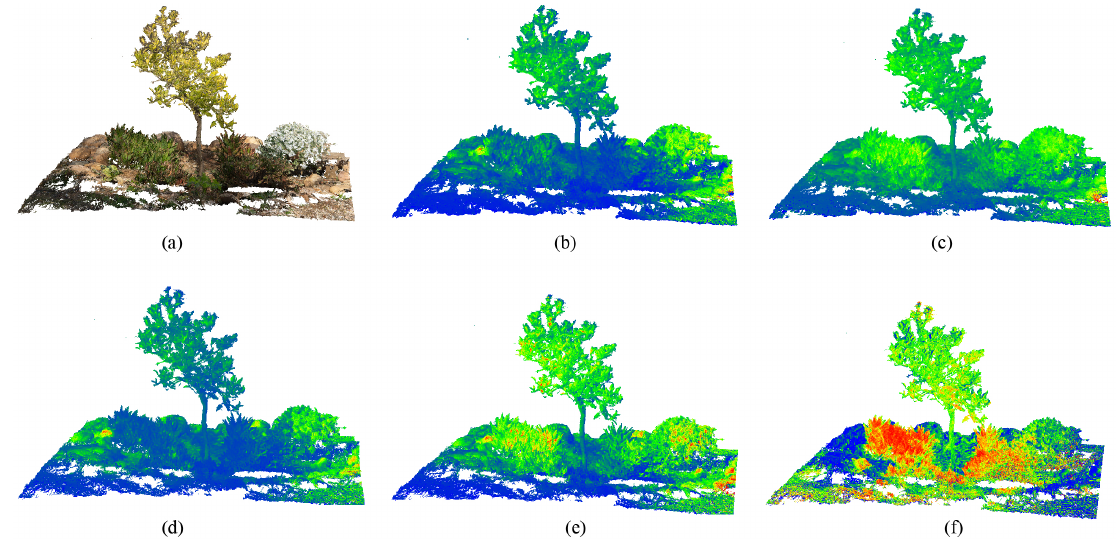
Figure 8. The studied observations of the point cloud: ( a ) RGB color; and the multispectral bands: ( b ) green, ( c ) NIR, ( d ) Red, ( e ) REG and ( f ) NDVI.